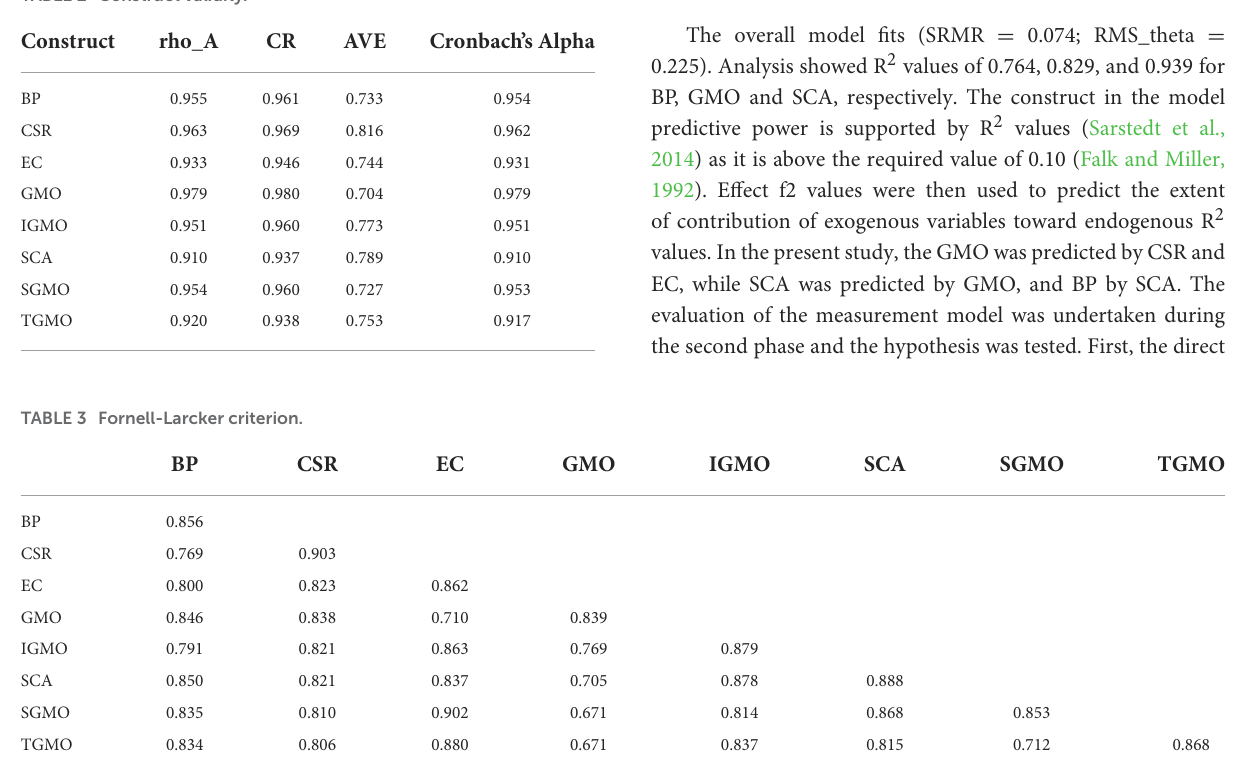
TABLE 2 Construct validity.